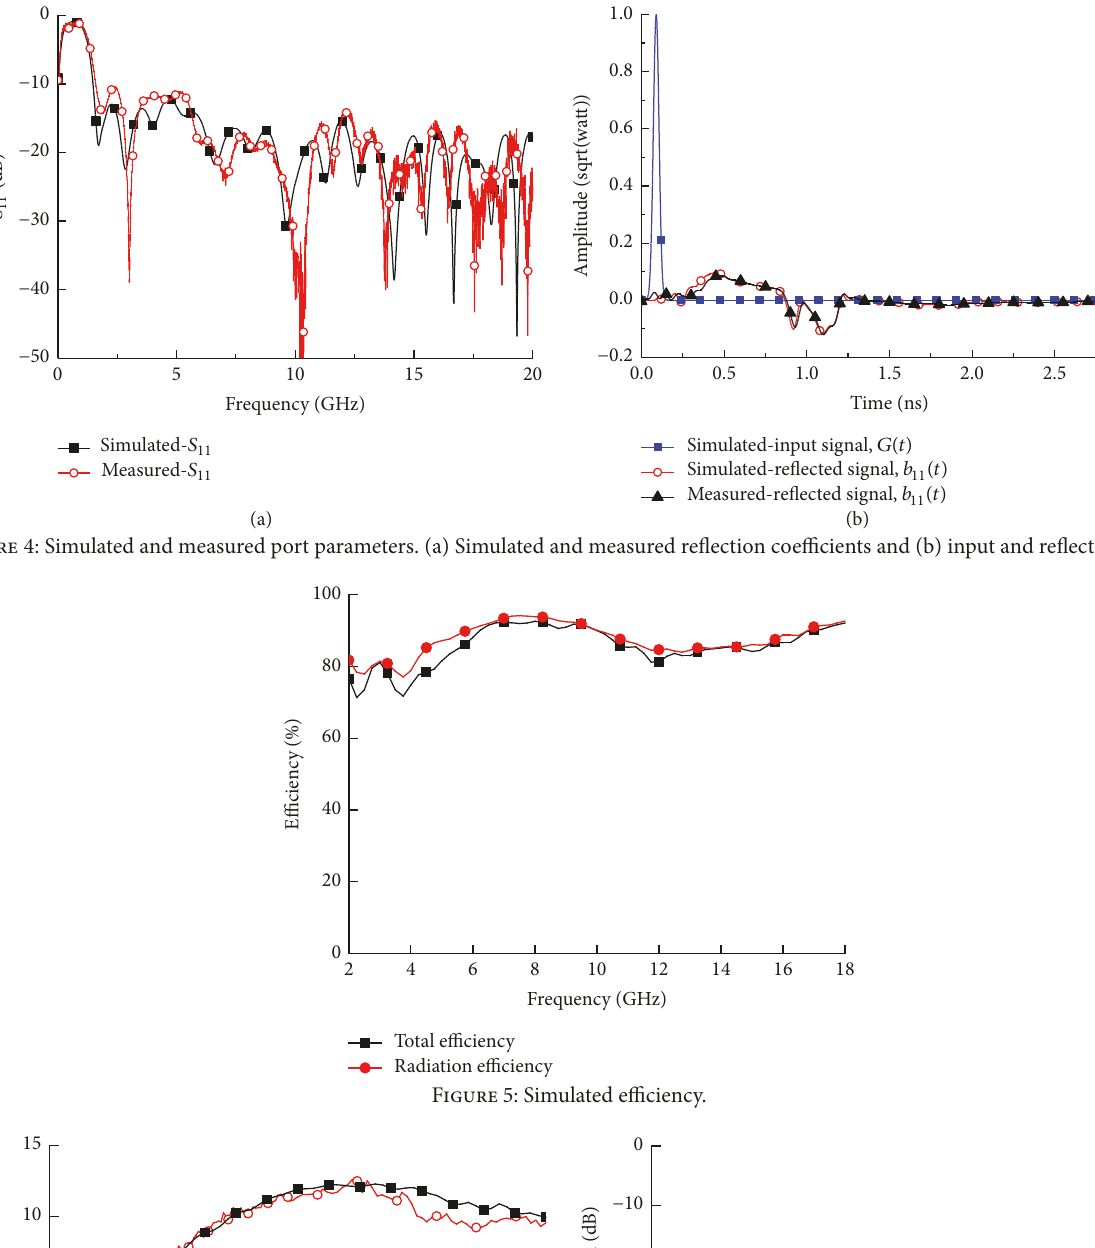
Figure 5: Simulated efficiency.